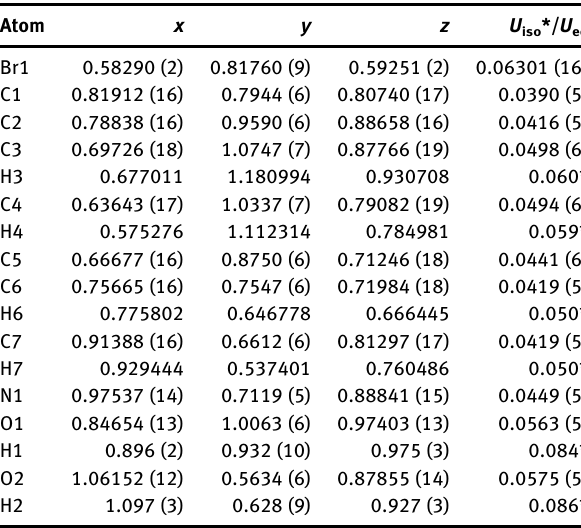
Table  : Fractional atomic coordinates and isotropic or equivalent isotropic displacement parameters (Å 